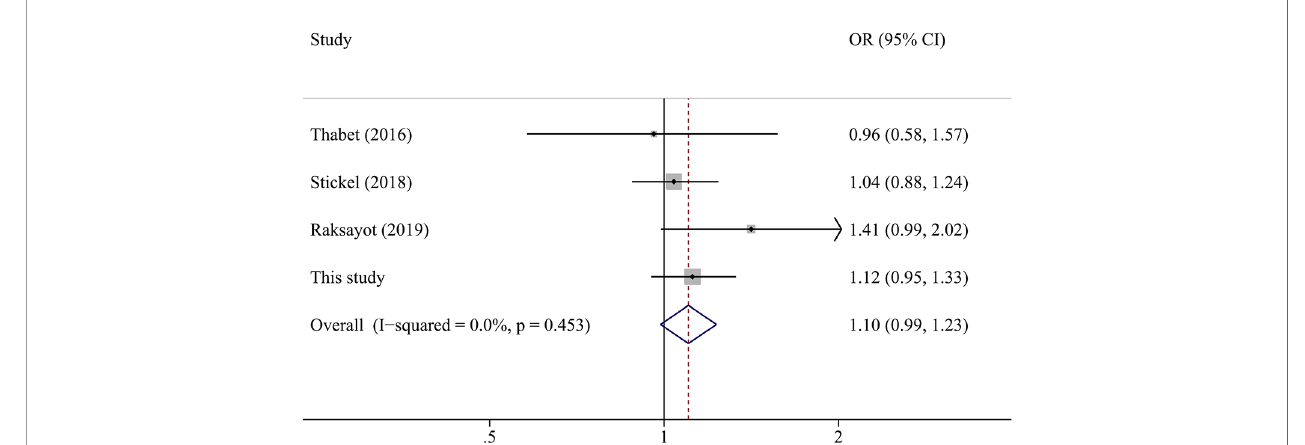
FIGURE 2 | The forest plot of the association between MBOAT7-TMC4 rs641738 and HCC risk under the allelic model.